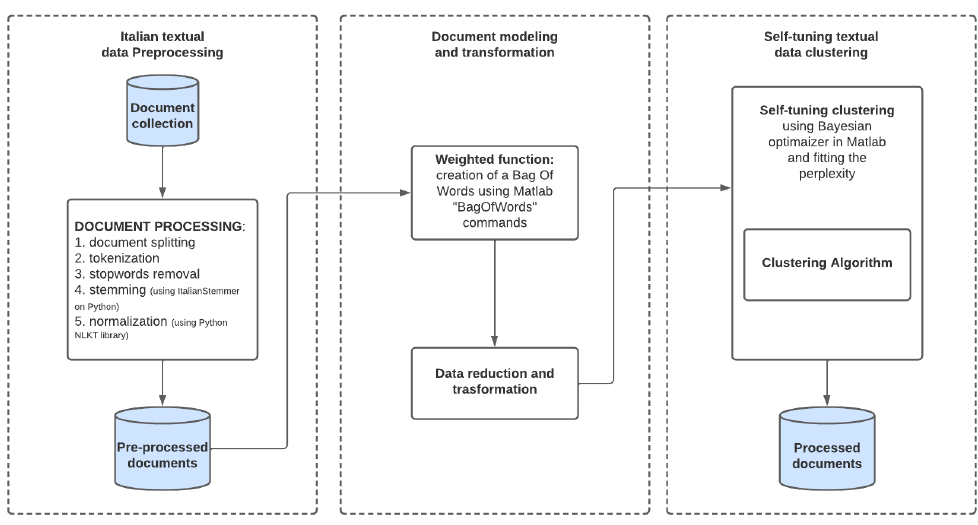
Figure 1. General schema of data processing and